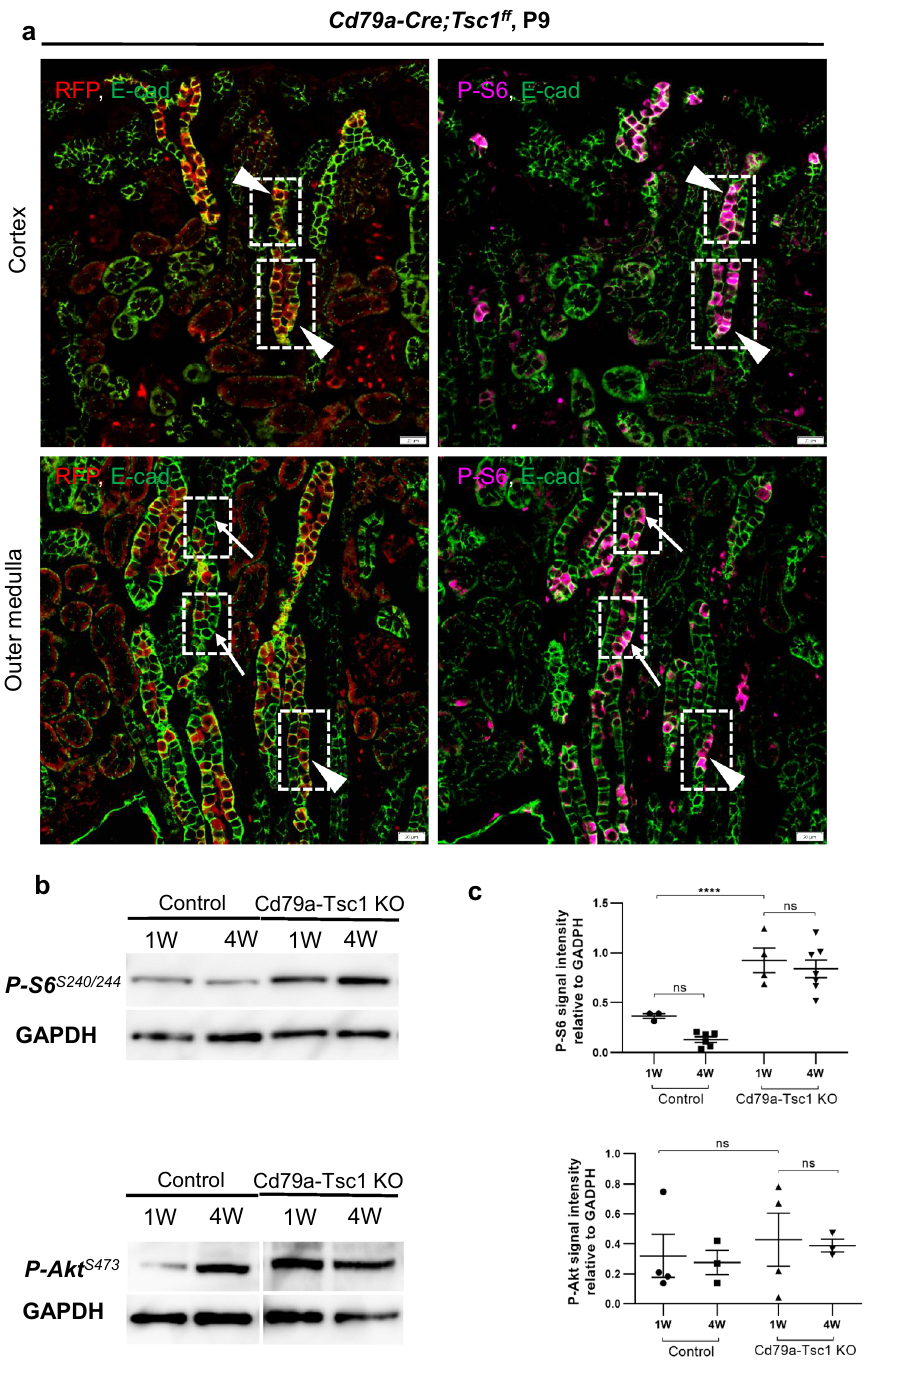
Figure 5. Autonomous and non-autonomous mTORC1 activation in pre-cystic tubules of Cd79a-Tsc1 knockout (KO) kidneys. ( a ) Two adjacent sections (3–5 µm) of Cd79a-Cre;Tsc1ff.;RFP f/ + mice at postnatal day (P) 9 are stained with antibodies against red fluorescent protein (RFP, a marker of Cd79a-Cre activity), phosphorylated (p)-S6 (an indicator of mTORC1 activation, magenta), and E-cadherin (E-cad, a marker of distal and collecting ducts, green). RFP signals are red in the cytoplasm, but are occasionally yellow when they merge with E-cadherin on the basal-lateral plasma membrane. Some epithelial cells coexpress p-S6 with RFP, while others are stained with the p-S6 only, suggesting that pre-cystic tubules are composed of two heterogeneous subpopulations of p-S6–positive cells: one undergoes Cre recombination (autonomous component, arrowheads) and the other does not (non-Cre recombination, non-autonomous component, arrows). ( b ) Immunoblot analysis of p-S6 (p-S6 S240/244 ) and p-Akt (p-Akt S473 ). Analysis of whole kidney lysates indicates that p-S6 expression is enriched in Cd79a-Tsc1 KO kidneys compared to controls (upper panel). However, p-Akt abundance did not differ between the two groups (lower panel). The original gels was shown in Supplementary Fig. S12. ( c ) Quantification analysis. In Cd79a-Tsc1 KO kidneys, p-S6 and p-Akt expression levels at 1 week of age did not differ from those at 4 weeks. Data represent mean ± SEM and were statistically analyzed by one-way ANOVA. **** P <